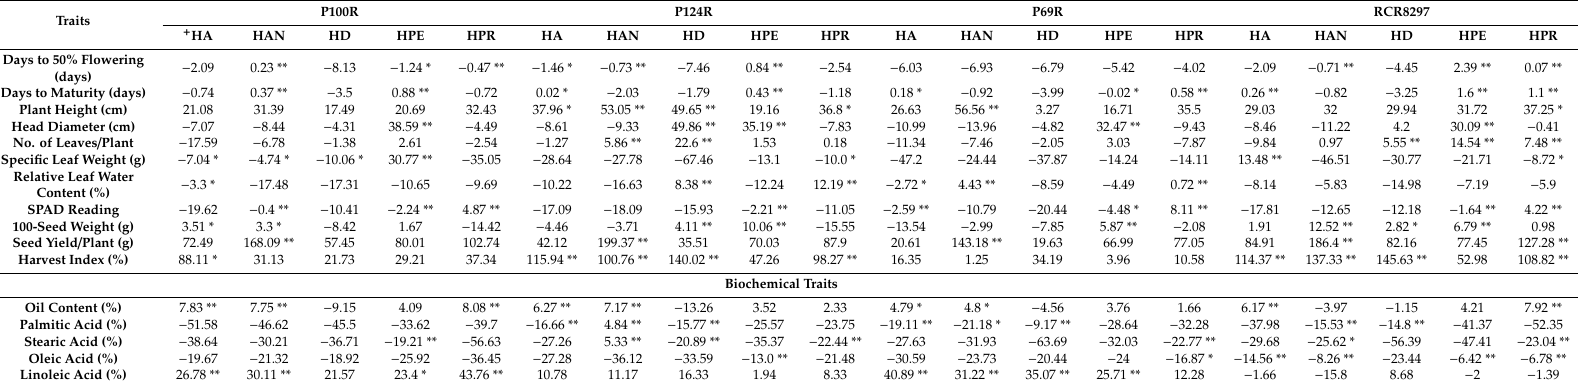
Table 1. Heterosis over better-parent values (BPH, %) among cytoplasmic male sterile (CMS) sources representing five di ff erent species of sunflower for morphophysiological, yield, and biochemical traits under normal irrigation conditions.